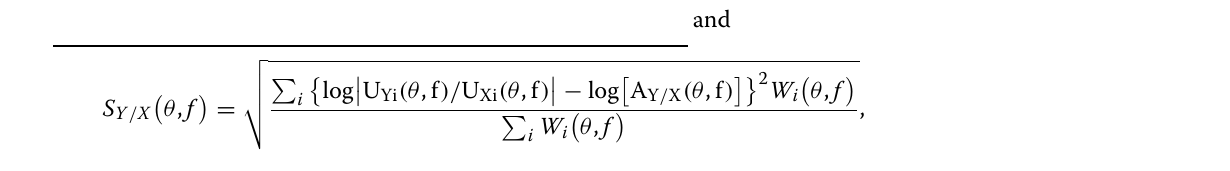
Table 2 Specifications of S‑net, ETMC, and DONET relevant to this study S‑net ETMC Type of observation system